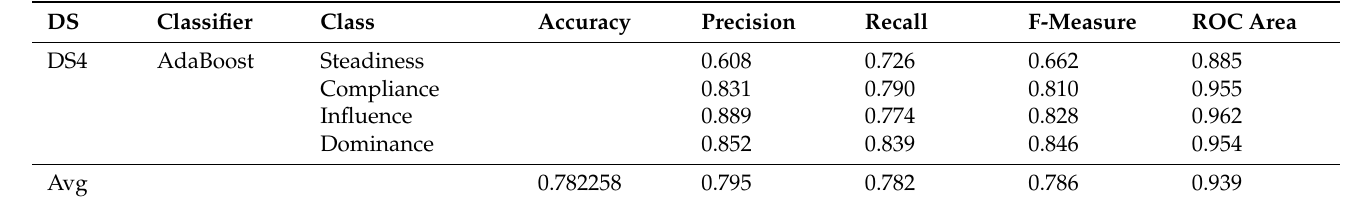
Table 12. Measures for the best classifier.